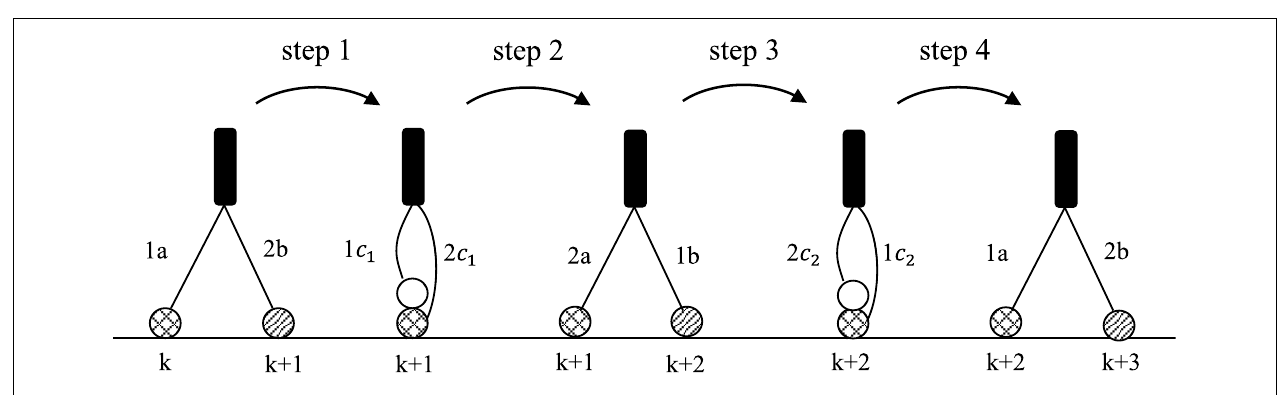
leg as tightly connected to the substrate (crossed circle). The loosely bound states connected to the substrate are omitted (see Figure 2 ).